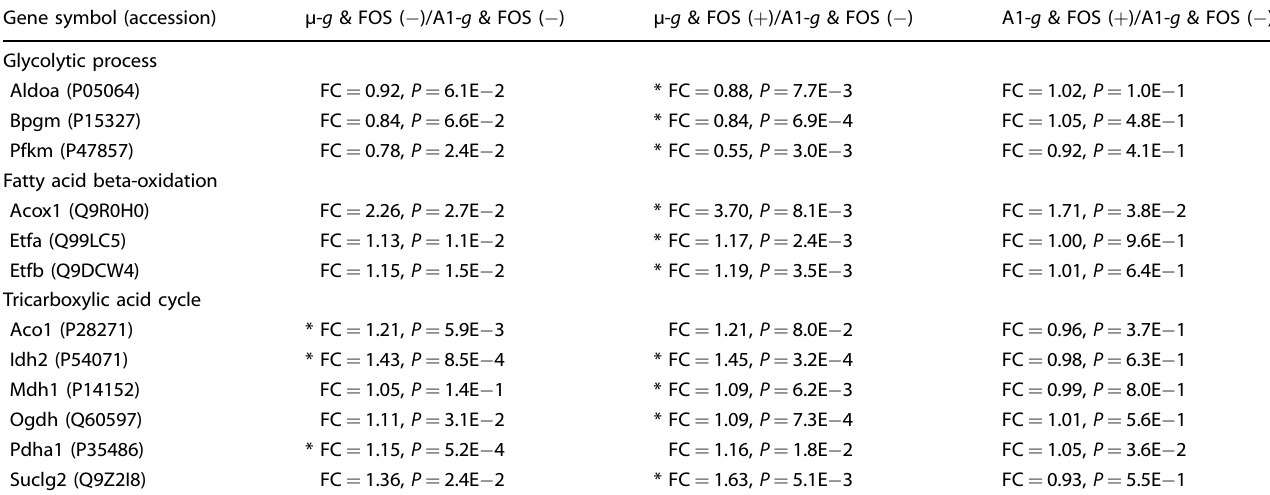
Table 6. Responses of extensor digitorum longus (EDL) muscle proteins involved in metabolic processes to microgravity (µ- g ) or arti fi cial 1- g (A1- g ) exposure and/or fructo-oligosaccharide (FOS)